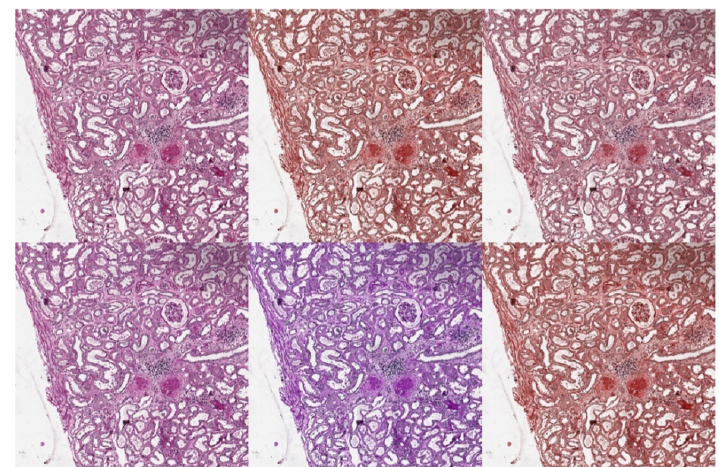
Figure 7. Elastic deformation example. Left: original image. Right: after elastic deformation with σ = 6.29, α = 340.